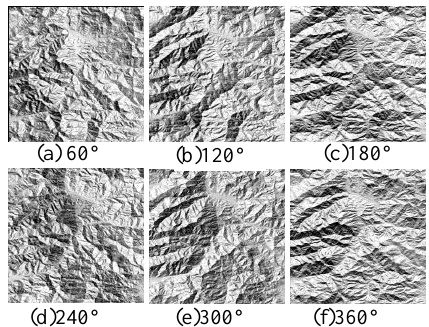
Figure 6. Terrain shading images of different azimuth angles (as annotated) and the same zenith angle